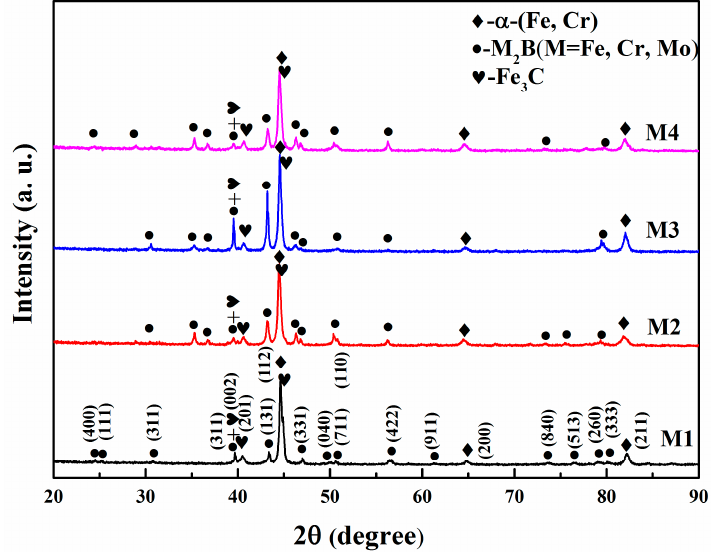
Figure 2. X-ray diffractometer (XRD) patterns of the as-cast Fe-Cr-B alloys with various Mo additions.